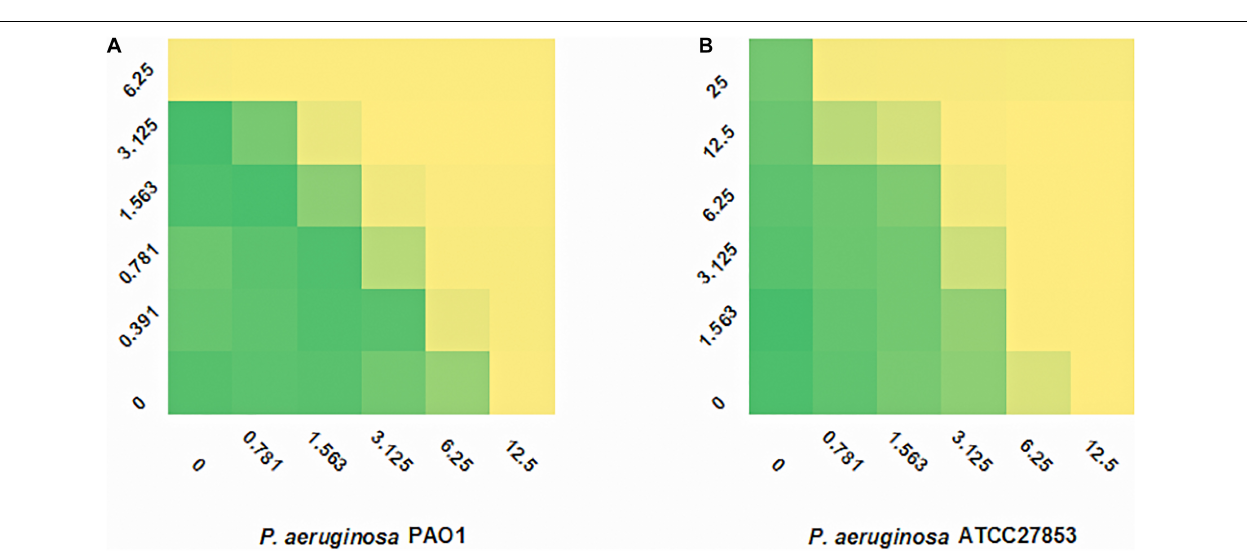
FIGURE 2 | FIC indexes of DMCT/SAAP-148 combination. Fractional inhibitory concentration (FIC) testing of DMCT and SAAP-148 alone and combination against PAO1 (A) and ATCC27853 (B) .